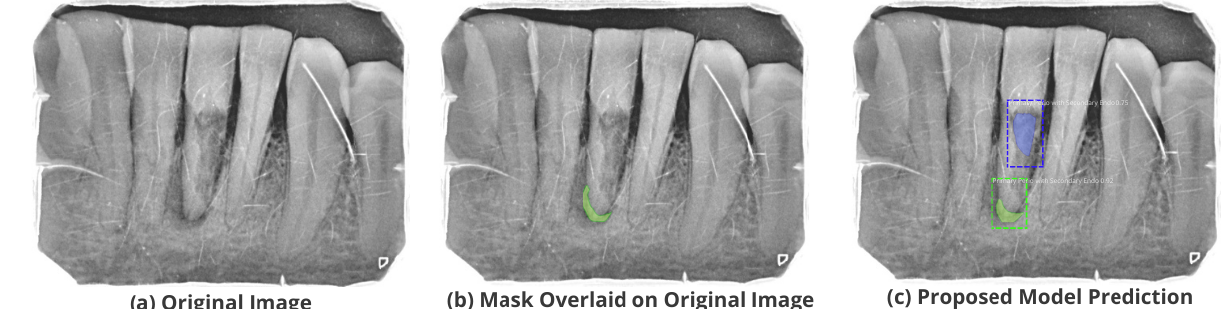
Figure 12. Test performance for the localization of a ’Primary Perio and Secondary Endo’ lesion.